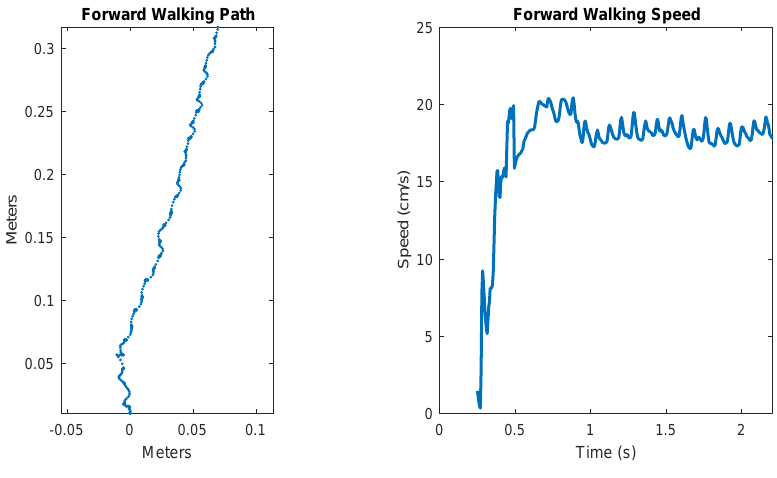
Figure 10. Forward walking path and